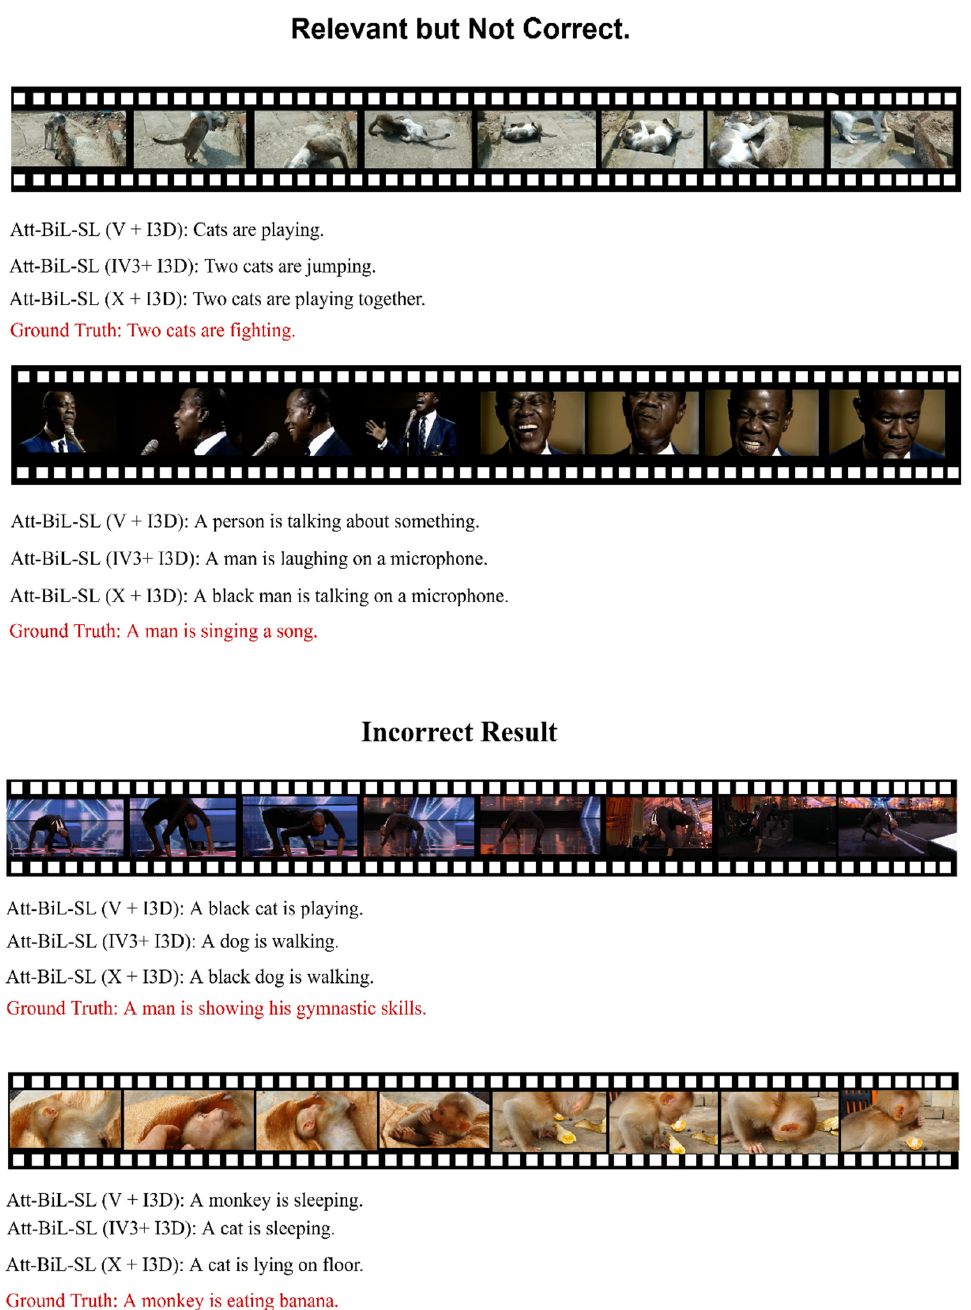
Figure 5. The example of some relevant video captioning but incorrect sentence generation and some incorrect sentence generation of our model. The generated sentences are also compared with ground truth sentences.